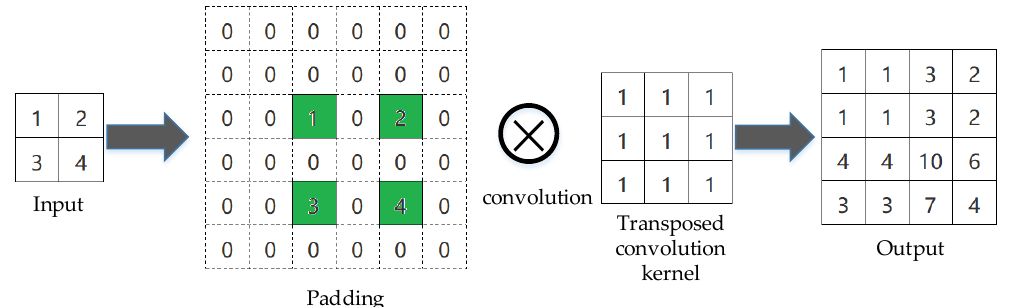
Figure 7. An example of transposed convolution operation.